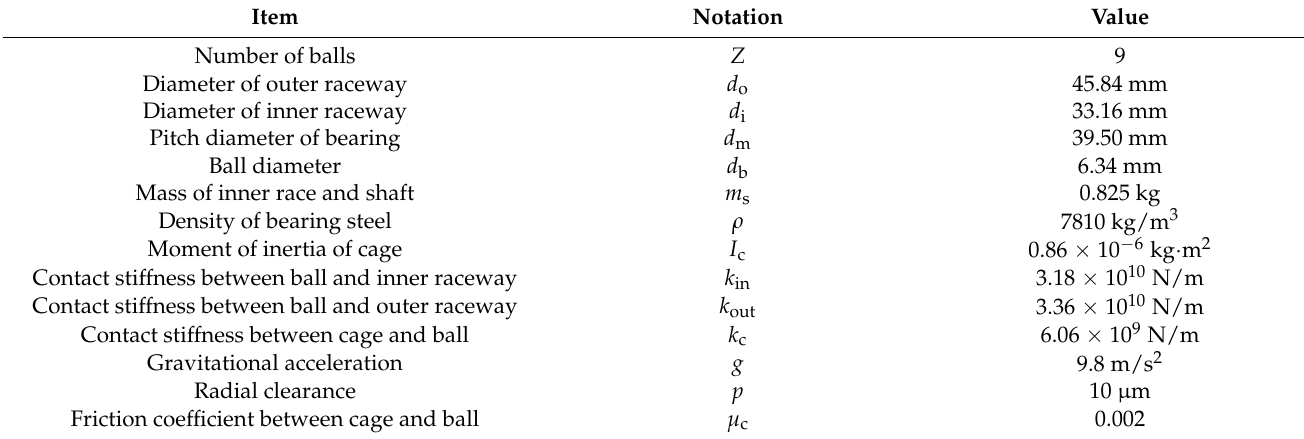
Table 1. Model parameters of the DGB